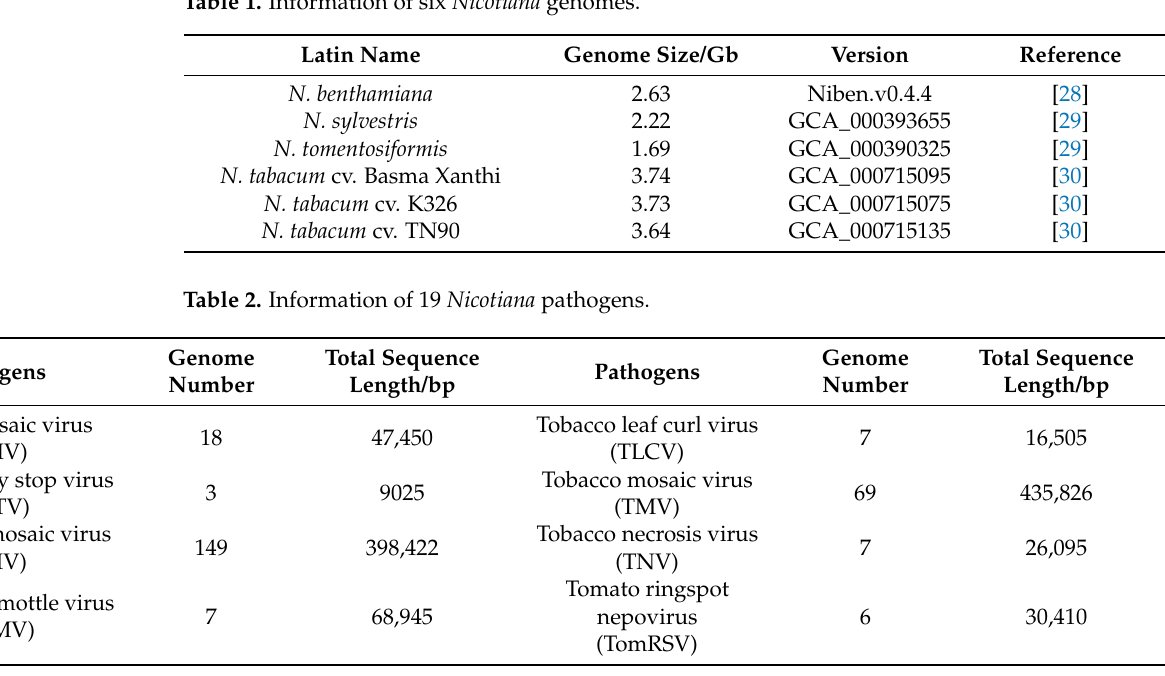
Table 1. Information of six Nicotiana genomes.